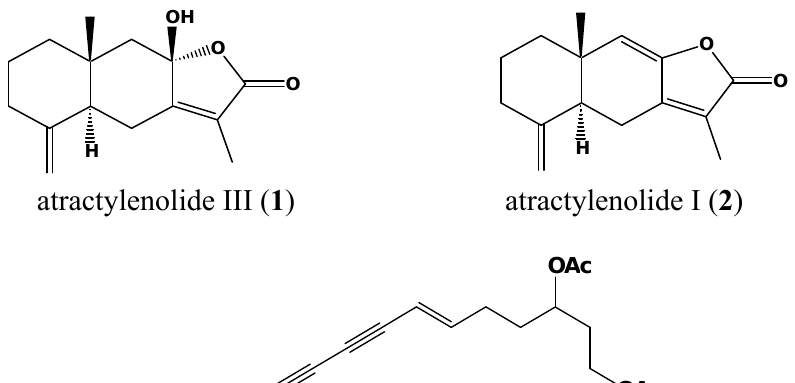
Table 1. Antimicrobial activity of A. japonica root MeOH extract and n -hexane, CHCl EtOAc, and n -BuOH fractions against S. aureus (ATCC 33591, ATCC 25923) strains. S. aureus strain